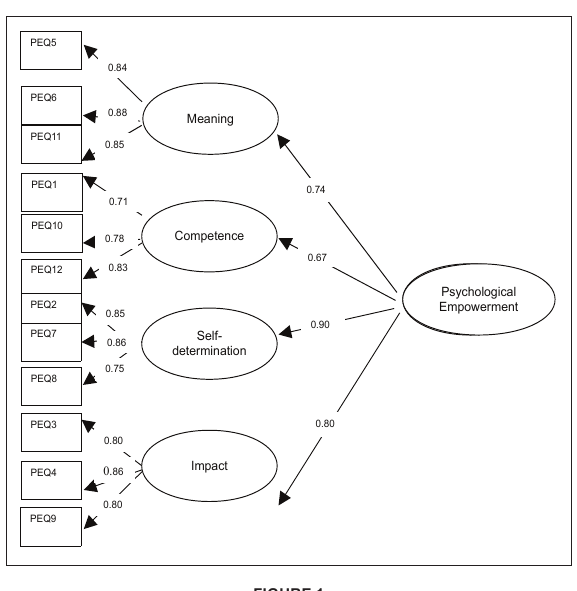
FIGURE 1 Standardised regression coefficients of a four-factor model of the PEQ (Note: All regression coefficients were statistically significant – p < 0.01)